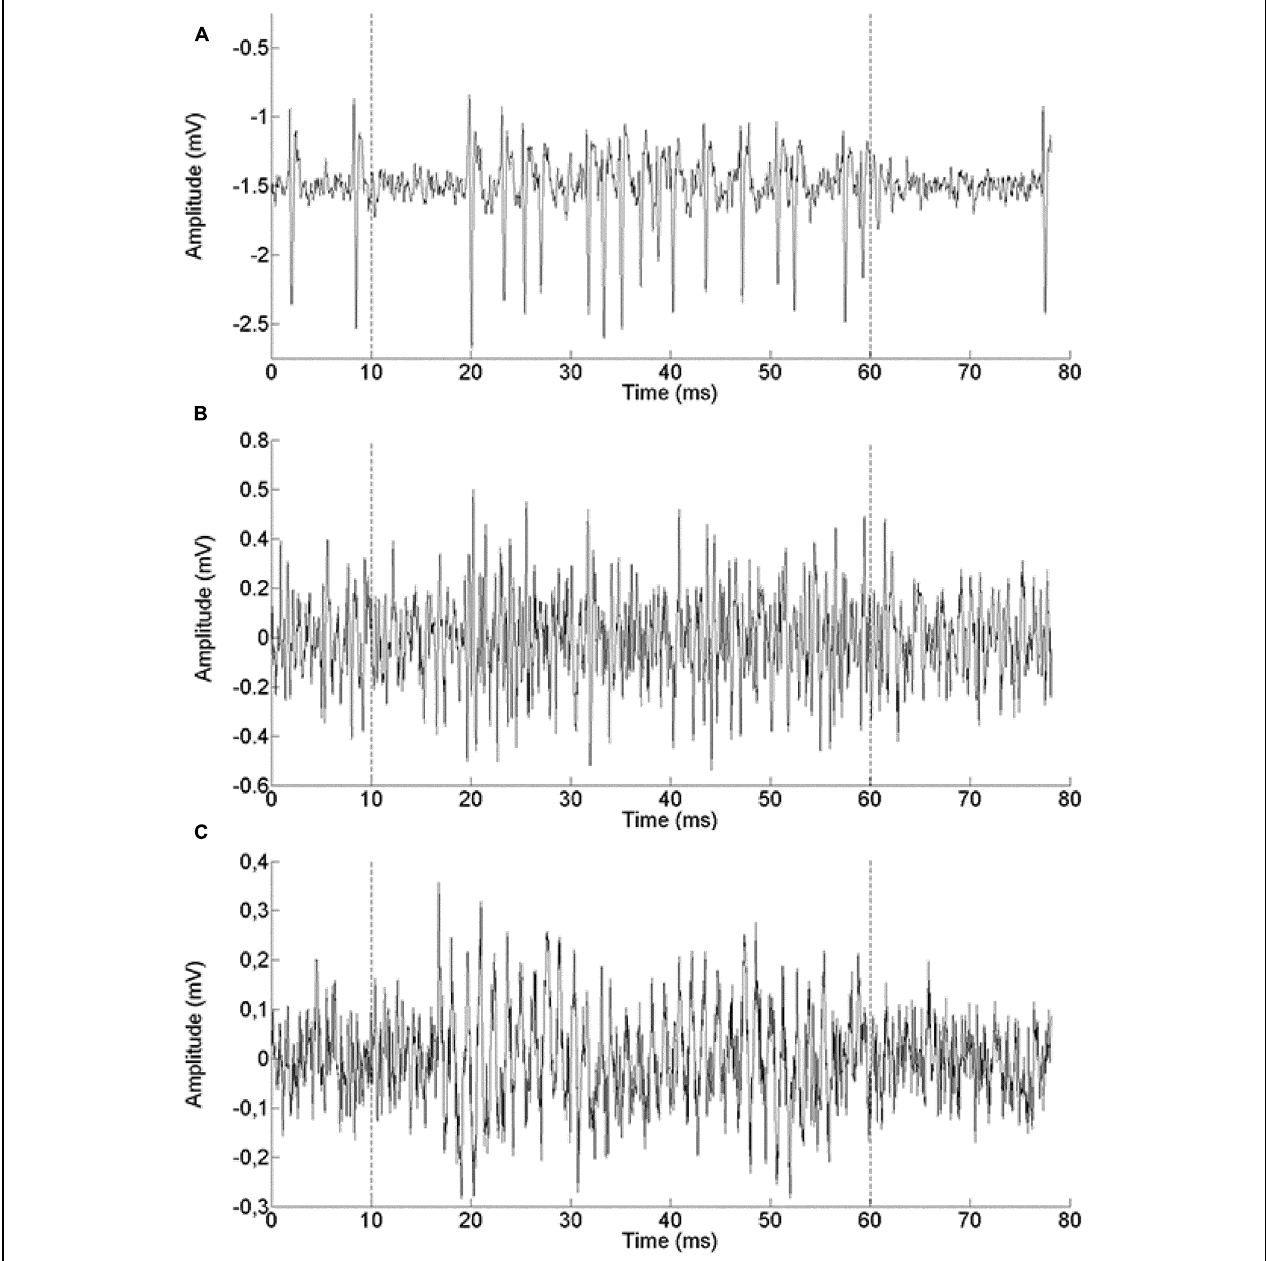
FIGURE 2 | Example single traces of recordings from a single unit (571 Hz BF, A), a multi-unit spike recording (500 Hz BF, B) and a neurophonic recording (850 Hz BF, C). The recording epoch lasted 80 ms. The stimulus was presented between 10 and 60 ms (marked by dashed